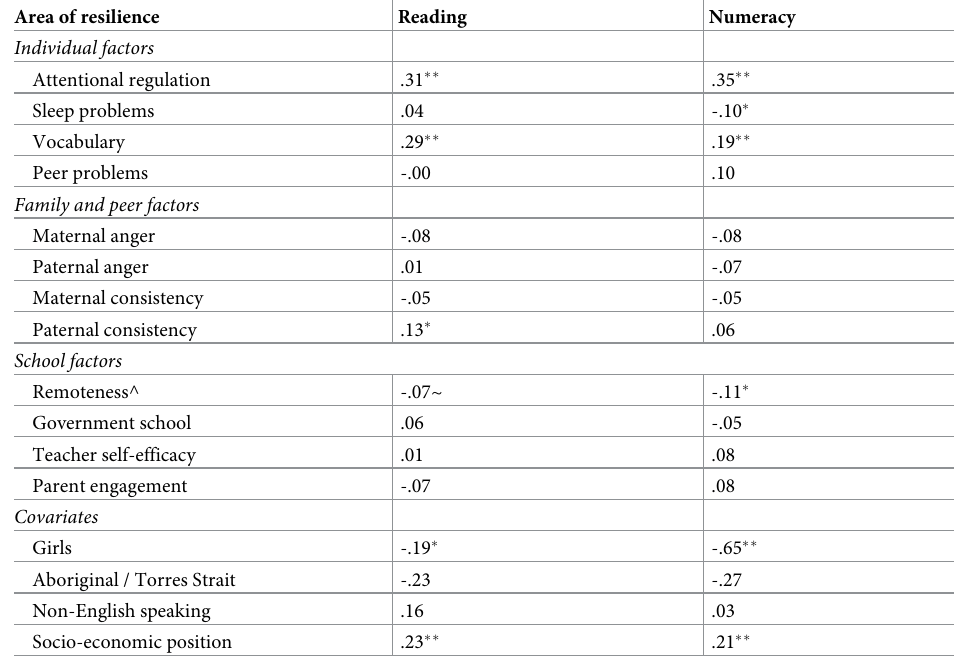
Table 5. Standardized estimates from the path model examining explanatory variables, covariates, and academic resilience group